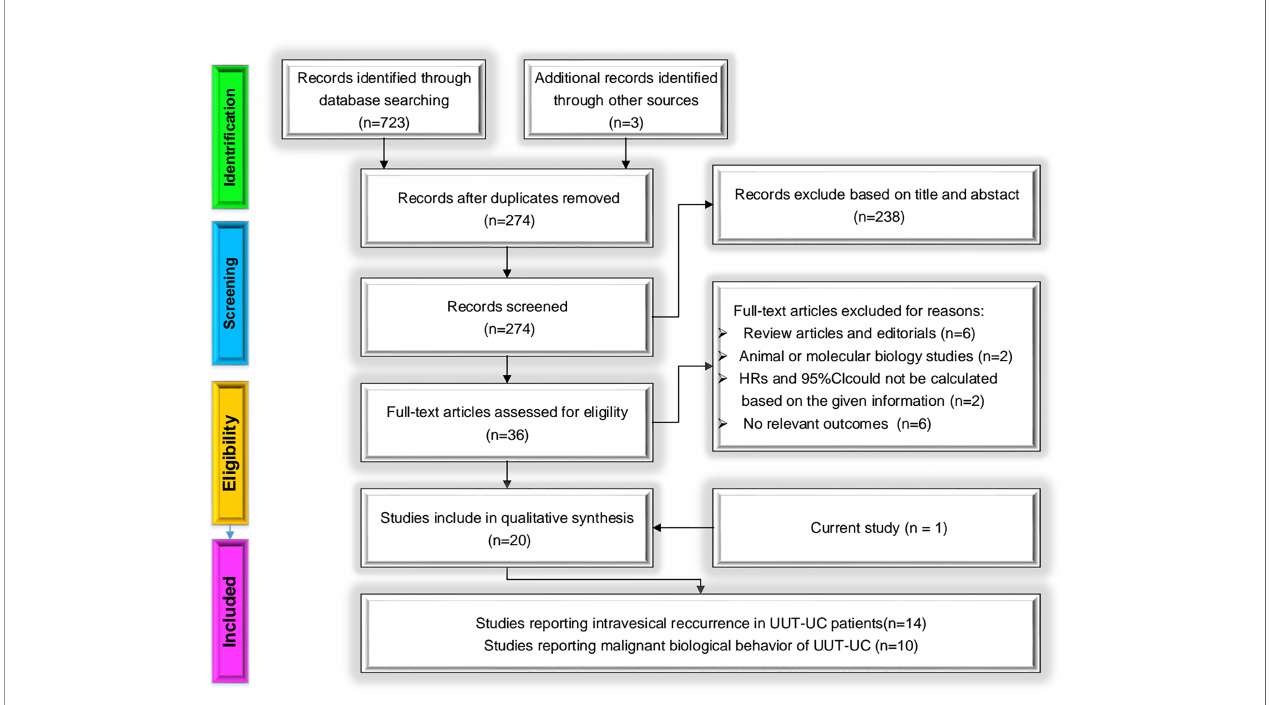
FIGURE 8 | Methodologic fl ow diagram for the selection of articles.